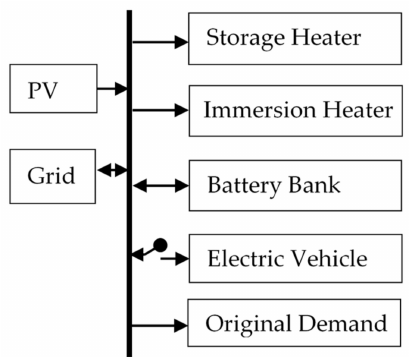
Figure 2. Illustration of electrical bus in the household, the di ff erent elements connected to it and the directions of power flows. The vertical line represents a connection bus in the households, the arrows indicate the possible direction(s) of the power flow and the switch in the electric vehicle indicates that it can be connected or disconnected at di ff erent times of the